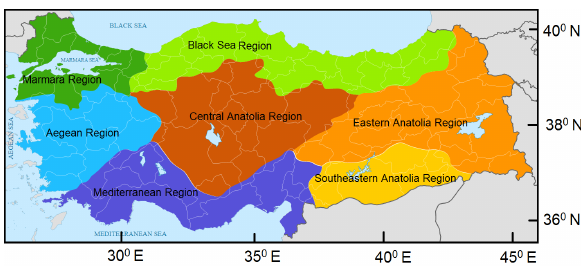
Figure 6: The seven official geographical region of